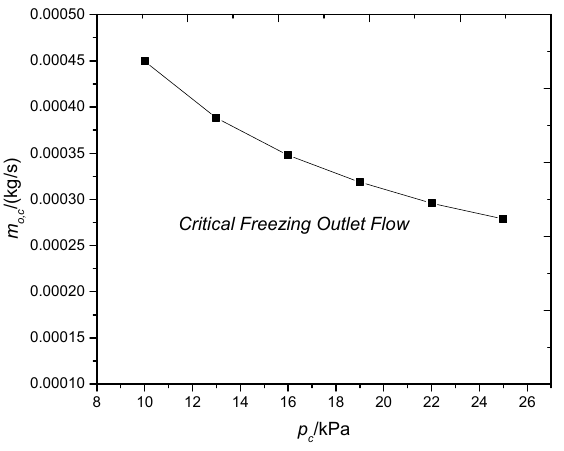
Figure 12. Critical freezing outlet flow versus back pressure.